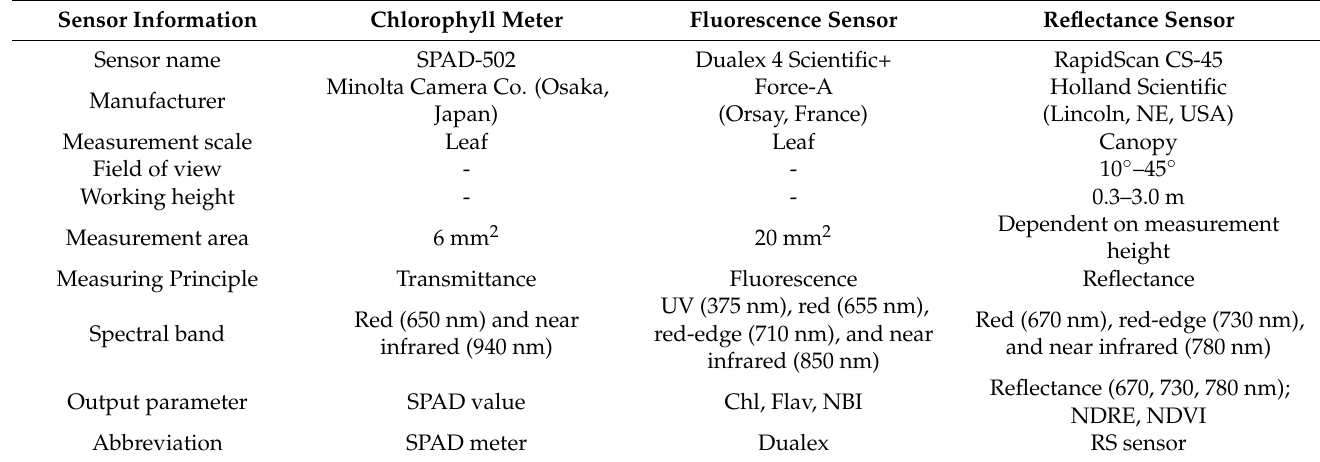
Figure 2. Images of the ( a ) SPAD-502 meter, ( b ) Dualex 4 Scientific+ sensor, and ( c ) RapidSCAN CS-45 sensor. Table 2. Characteristics of the three optical sensors.